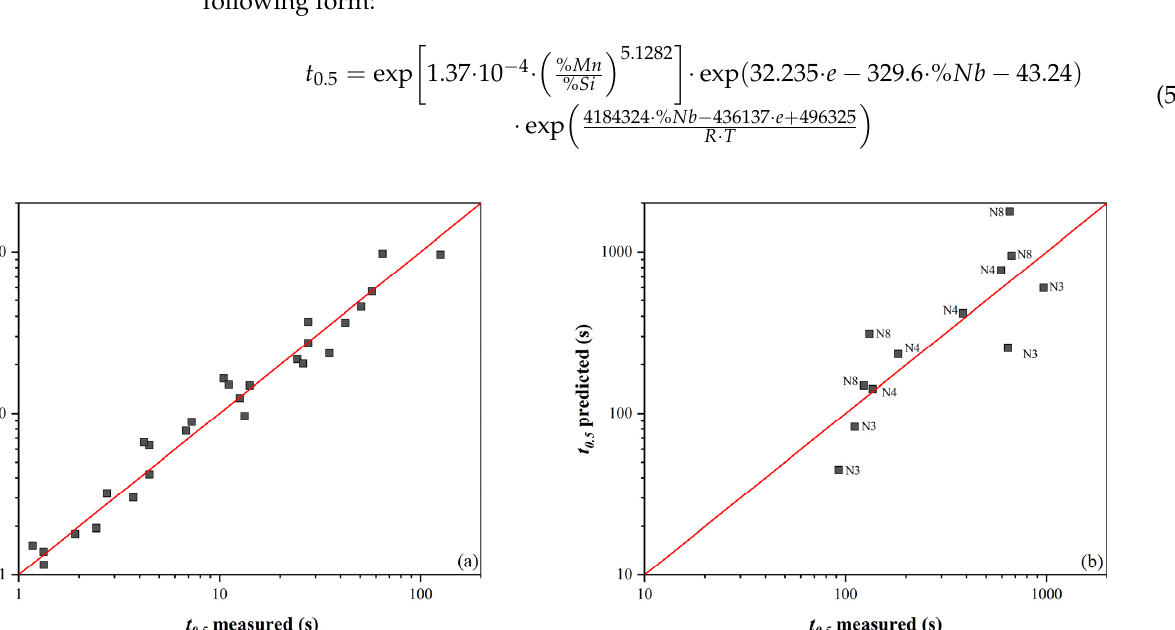
Figure 7. Comparison of measured and calculated t 0.5 values: ( a ) without SIP according to Equation (3), and ( b ) with SIP according to Equation (4) (data labels here represent steel designations.)